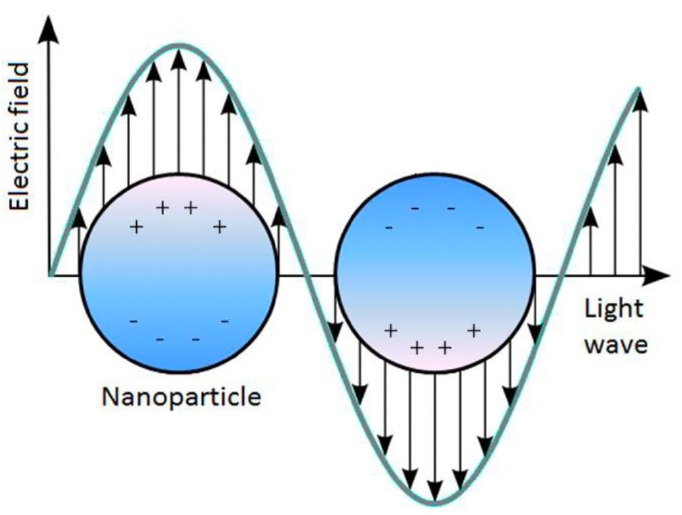
Figure 2. LSPR effect: plasmon oscillation for a AuNP [21].